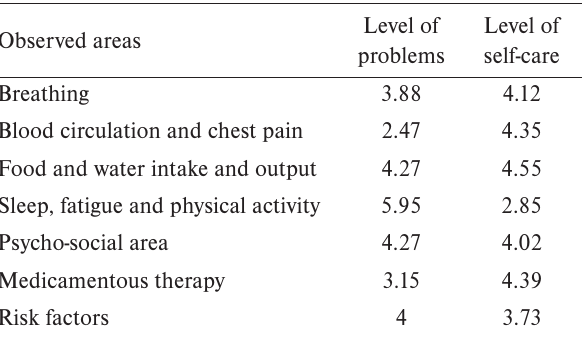
Table 4. The level of problems and the level of self-care in HF